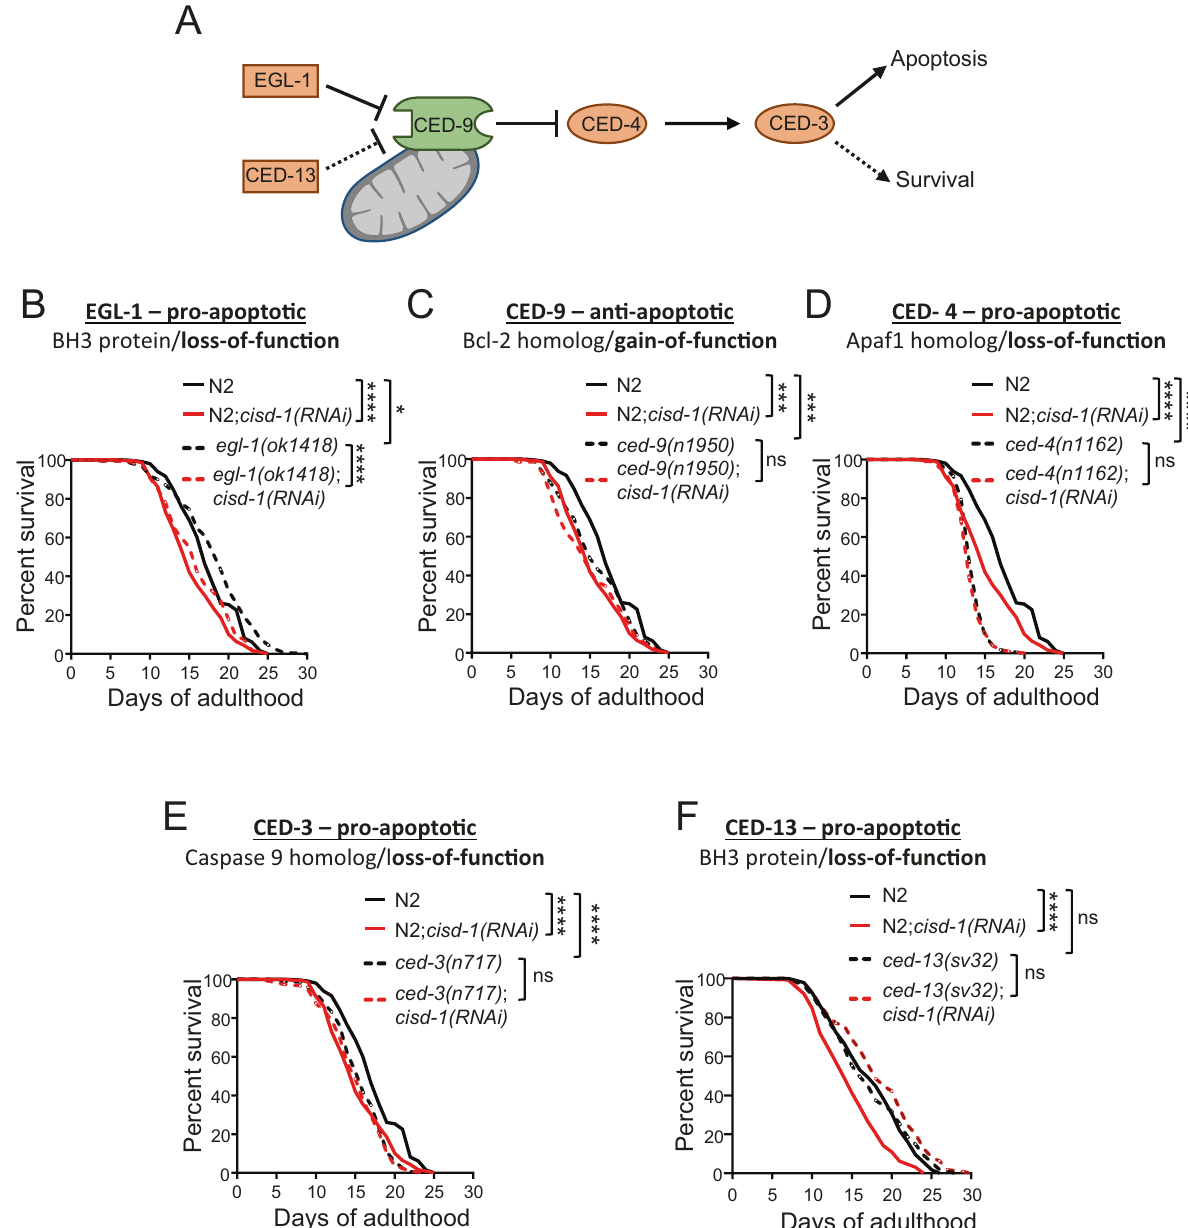
Fig. 3 The intrinsic apoptosis pathway mediates CISD-1 pro-longevity effects. A Representation of the C. elegans apoptotic pathway. B Survival curves of wt (normal solid line) and egl-1(ok1418) (dashed line), treated with either empty vector (black line) or cisd-1(RNAi) (red line) from hatching (* P < 0.05, **** P < 0.0001, Log-rank/Mantel – Cox test). C Survival curves of wt (normal solid line) and ced-9(n1950) (dashed line), treated with either empty vector (black line) or cisd-1(RNAi) (red line) from hatching (ns P > 0.05, *** P < 0.001, Log-rank/Mantel-Cox test). D Survival curves of wt (normal solid line) and ced-4(n1162) (dashed line), treated with either empty vector (black line) or cisd-1(RNAi) (red line) from hatching (ns P > 0.05, **** P < 0.0001, Log-rank/Mantel – Cox test). E Survival curves of wt (normal solid line) and ced-3(n717) (dashed line), treated with either empty vector (black line) or cisd-1(RNAi) (red line) from hatching (ns P > 0.05, **** P < 0.0001, Log-rank/Mantel – Cox test). F Survival curves of wt (normal solid line) and ced-13(sv32) (dashed line), treated with either empty vector (black line) or cisd-1(RNAi) (red line) from hatching (ns P > 0.05, **** P < 0.0001, Log-rank/Mantel – Cox